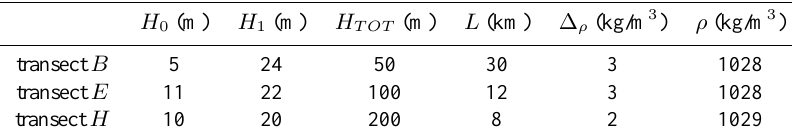
Table 1. Values for the parameters used in the calculation of the free coastal trapped modes (see Fig. 12 for the explanation of the variables used), obtained from CTD measurements during August 1995. In the Table, ∆ ρ = ρ 2 − ρ 1 and ρ = ρ 2